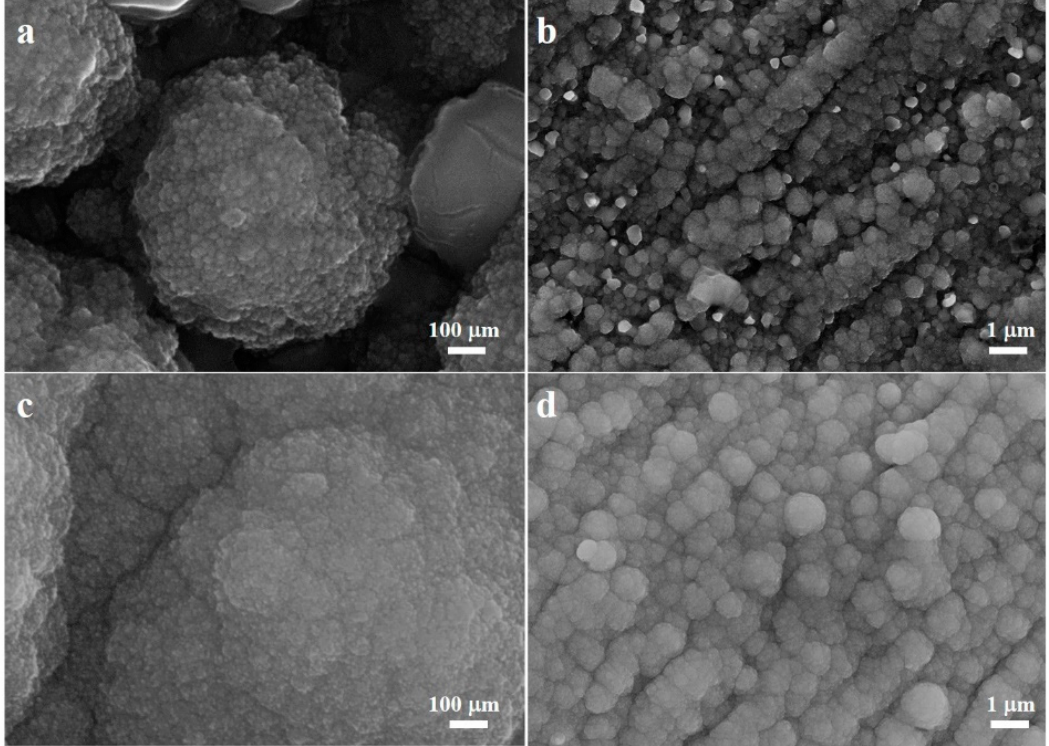
Figure 2. The FESEM pattern of the Cel-CS electrode ( a , b ) and the Cu-CS electrode ( c , d ) with different magnifications.